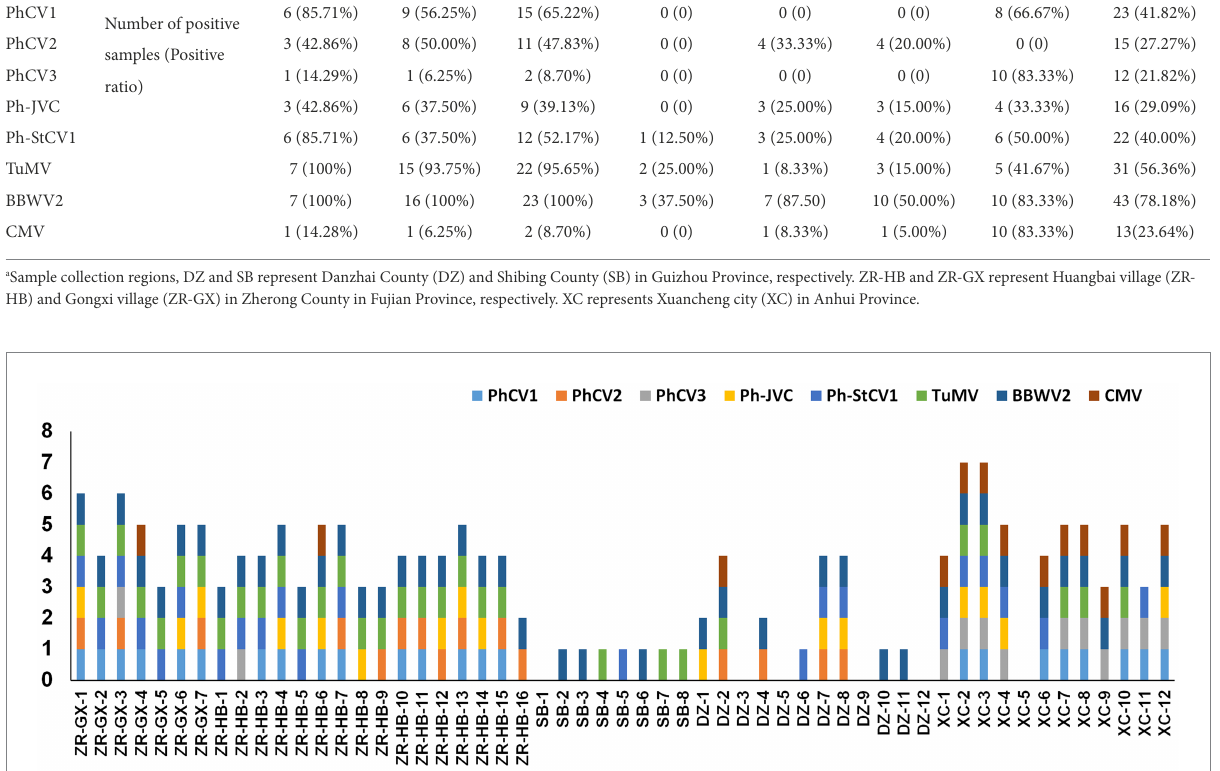
TABLE 3 RT-PCR analysis of the incidence of PhCV1, PhCV2, PhCV3, Ph-JVC, Ph-StCV1, TuMV, BBWV2, and CMV in Pseudostellaria heterophylla collected from five independent locations, including ZR-GX, ZR-HB, SB, DZ, and XC.